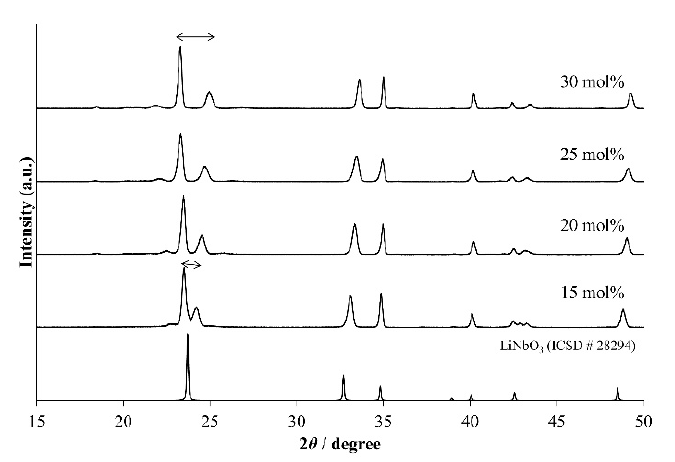
Figure 5. XRD patterns of LNT solid solutions with Ti 15, 20, 25, and 30 mol % at 1273 K for 1 h under 0.35 MPa.